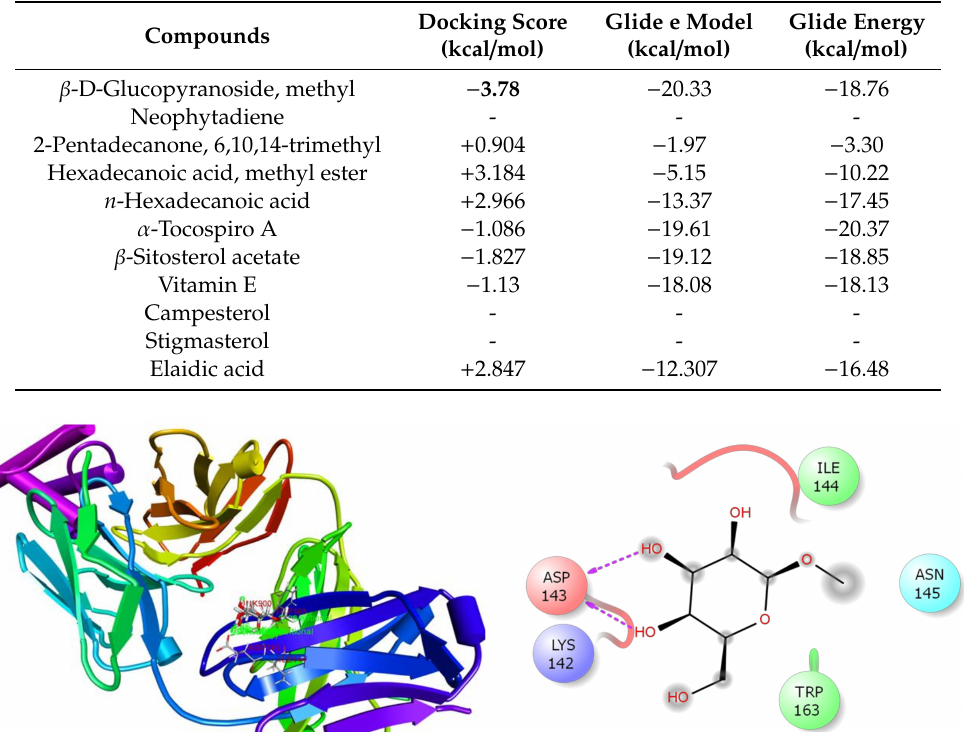
Table 3. Docking score of the identified compounds with potassium channel receptor (pdb: 4UUJ) for anxiolytic activity. Bold indicate the highest docking score.